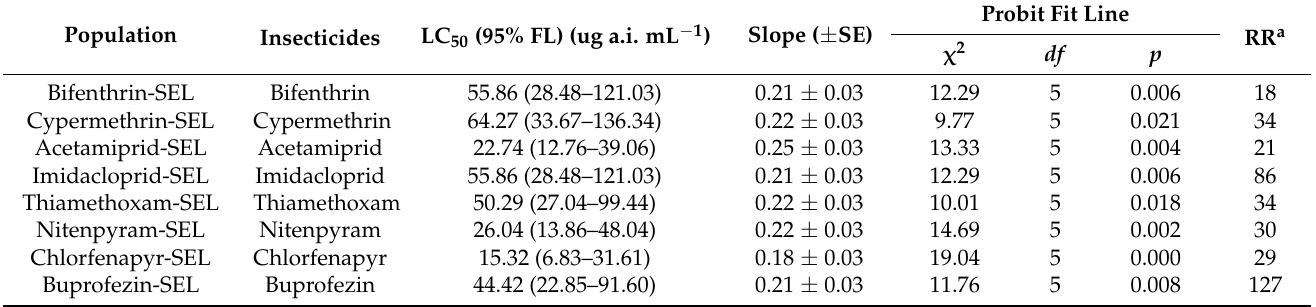
Table 3. The response of B. tabaci to different insecticides after five generations of selection under the laboratory conditions.